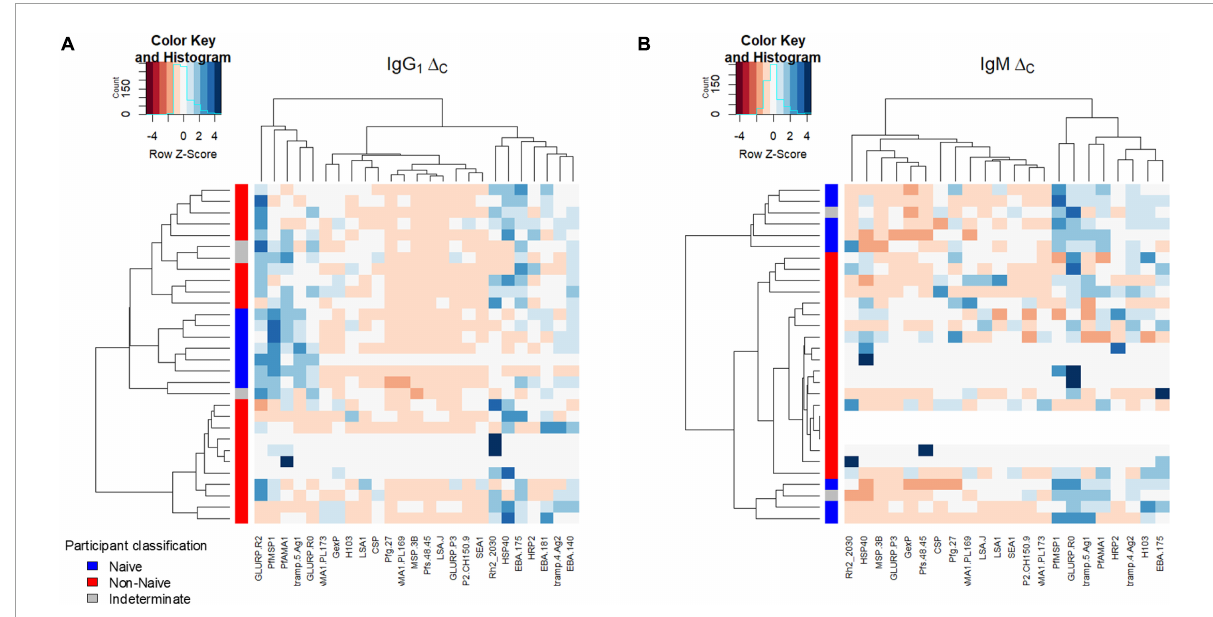
FIGURE5 Hierarchical relationship among study participants shown for the (cid:49) C parameter. Clustering of (cid:49) C by P. falciparum antigen response (columns) and participants (rows) for IgG 1 (A) and IgM (B) . Intensity of color shading within the plot indicated by the magnitude of the standard score (Z